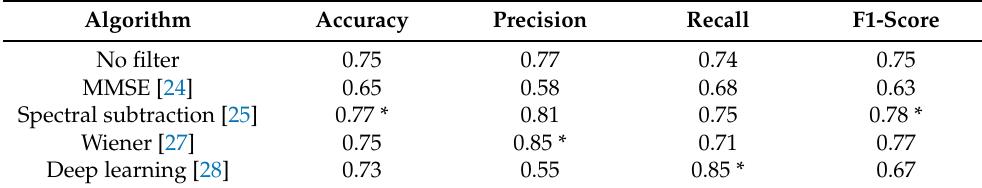
Table 2. Babble Noise SNR − 5. * is the best result for each particular measure.